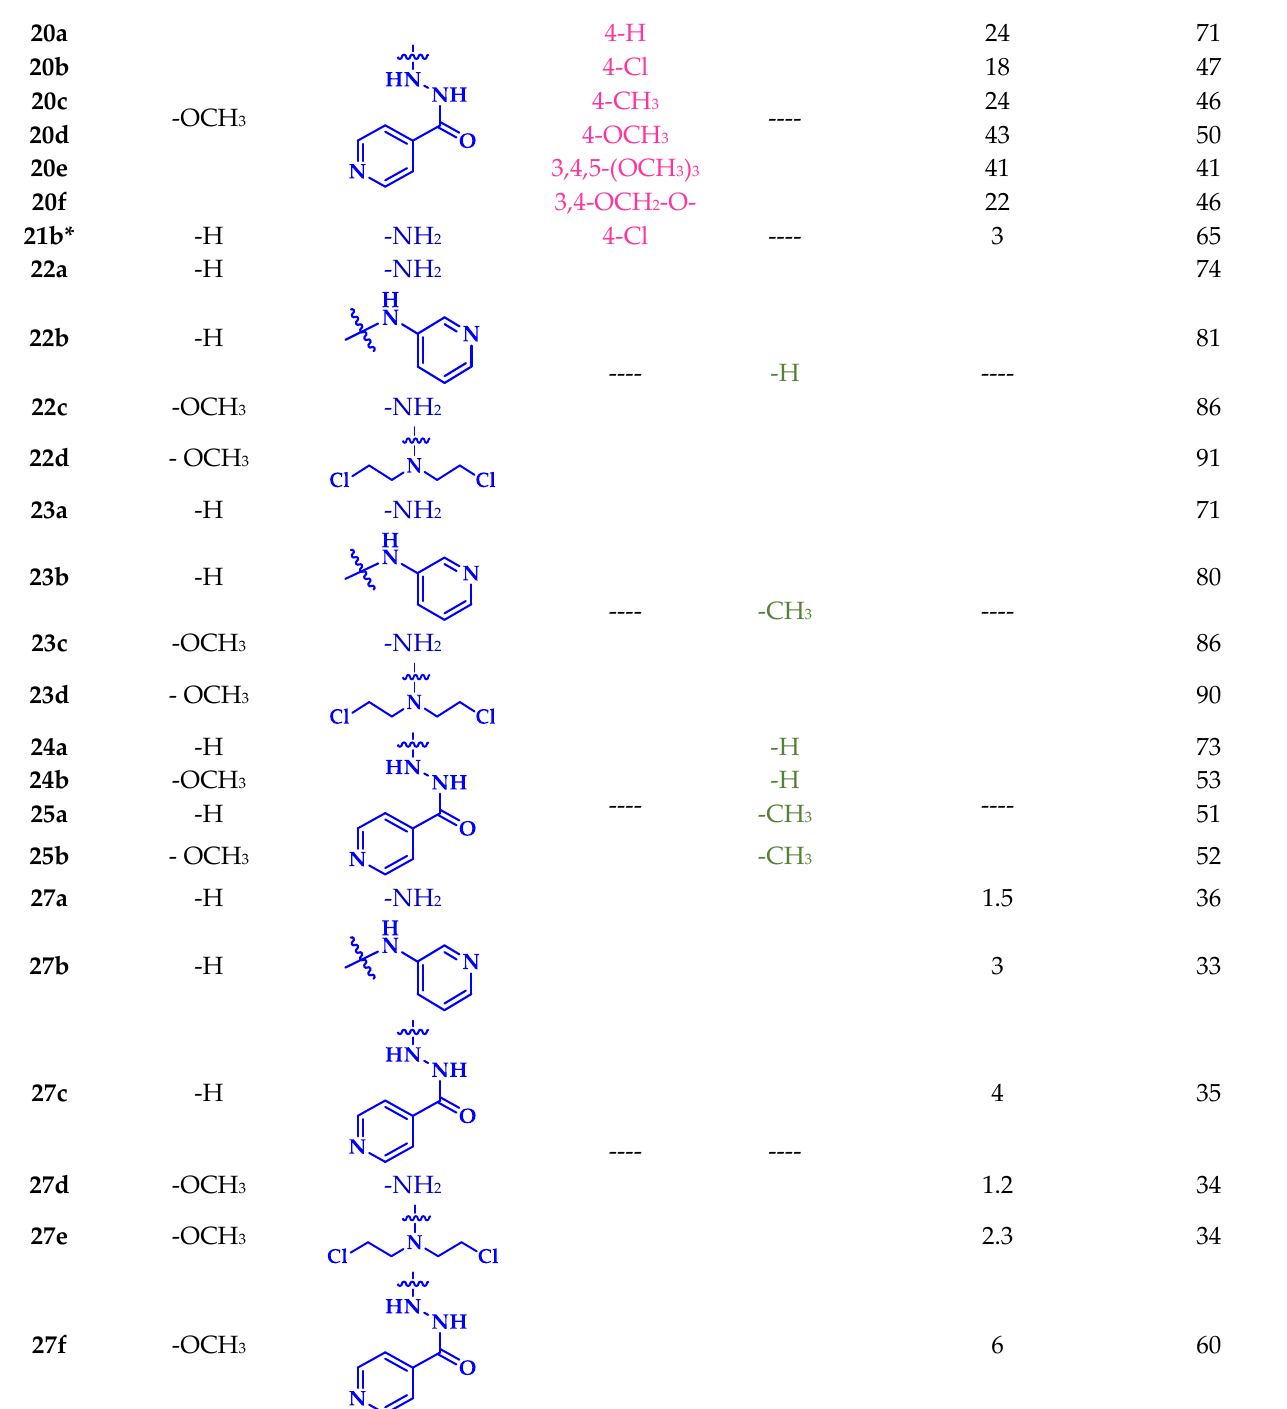
Scheme 2. General procedure for the synthesis of new chalcone–sulfonamide (16-20)a-f , pyrazoline–sulfonamide (22-23)a-d and (24-25)a-b , and carbothioamide–sulfonamide 27a-f : ( i ) EtOH, NaOH 50% ( w/v ), r.t; ( ii ) NH 2 -NH 2 · H 2 O, EtOH, reflux; ( iii ) Ac 2 O or HCOOH, r.t; ( iv ) NH 2 -NH 2 · H 2 O, EtOH, r.t; ( v ) EtOH, NaOH, 60 °C. * Reported in our previous work [56].